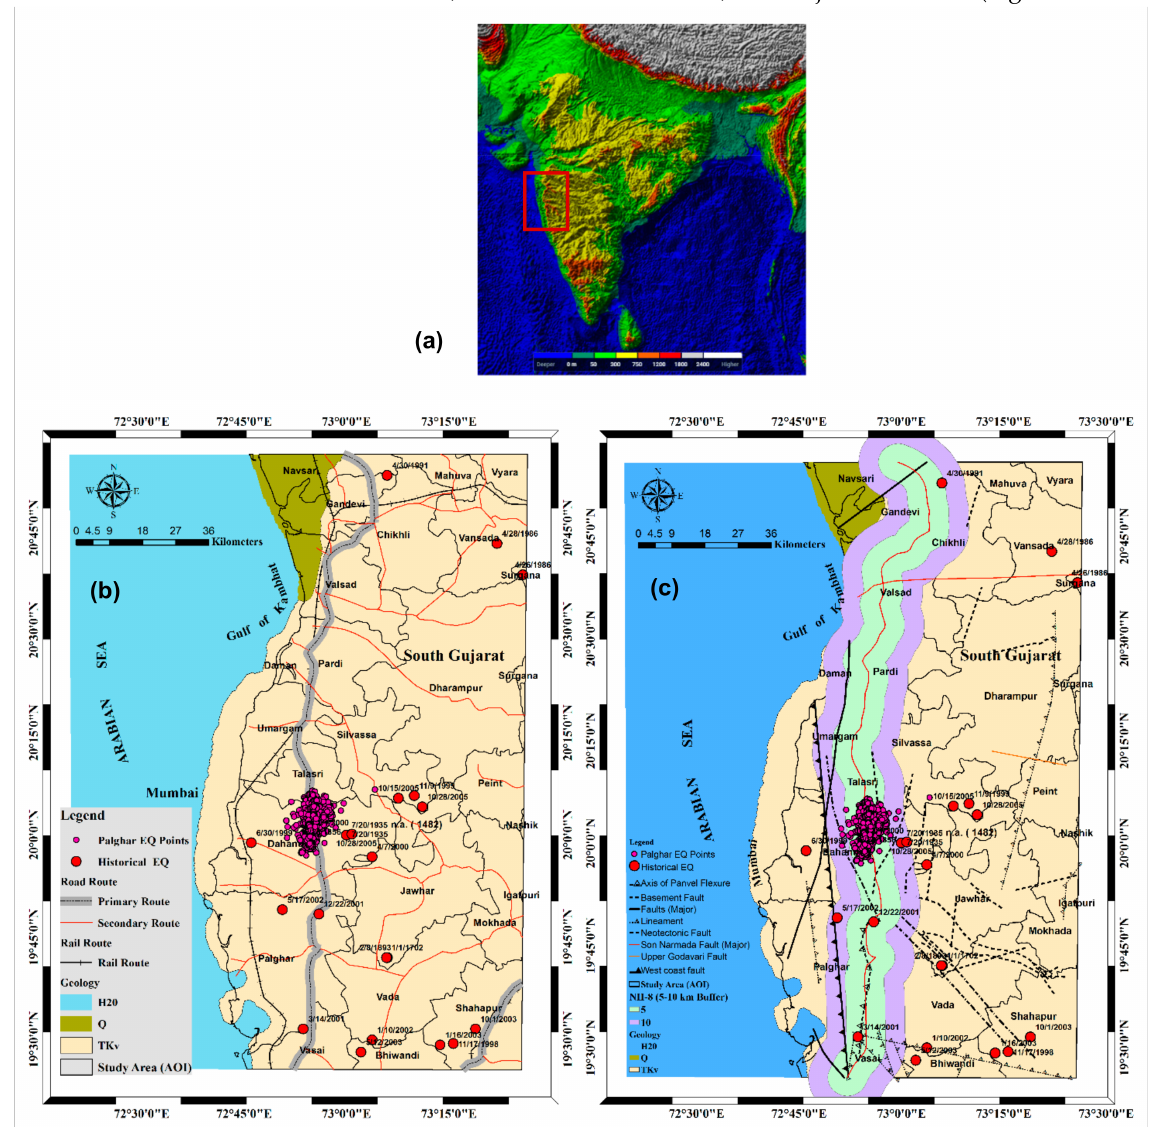
Figure 2. 3D Terrain structure of the Indian shield, general geology and other geographical dis- tribution of the study area; ( a ) 3D view of the terrain of the Indian shield areas (3D image using Land Viewer 2020); and red bounding box on this image shows broad regions of the study area applicable for Figure 2b,c. ( b ) General geology (masking from Geologic map of South Asia shapefile; https://certmapper.cr.usgs.gov/data/ accessed on 3 November 2020) [66] with other geographical information such as road and rail network distribution (masking from Geofabrik, OpenStreet Map data; http://download.geofabrik.de/asia.html (accessed on 3 November 2021)) [65] with recent Palghar earthquake swarm epicenters (3.5 ≤ M L ) and historical earthquakes (5.7 ≤ M L ) distribution since 1702–2005 (based on all available earthquake catalog, taken from 1200 AD to 2005) [34,67,68] where only 24 points (details of earthquake are given in Appendix A Table A1) are recorded within our AOI (red rectangle box); ( c ) Regional faults distribution in the western parts of India along with location of the observed earthquake swarms (distribution of earthquake epicenters during January and December 2020) and 10 km buffer zone created around highway NH-8 because recent earthquake swarms are clustered within buffer zone and along with historical earthquake points displaying over geology and regional